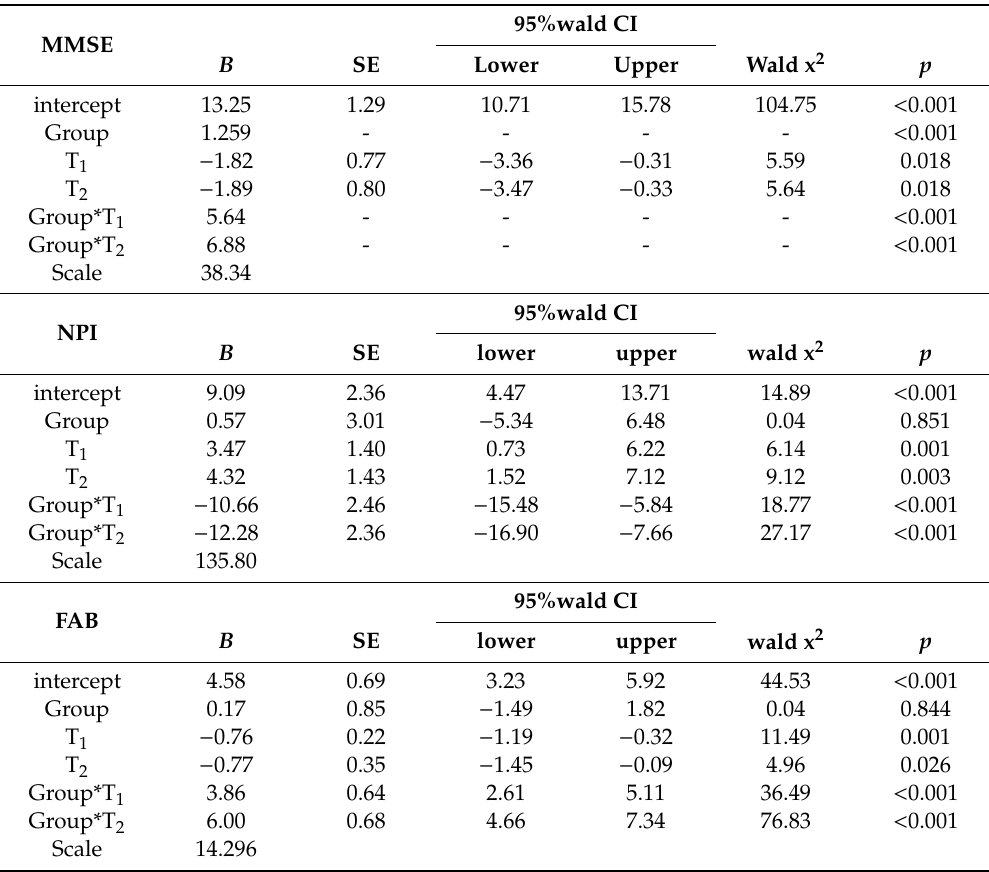
Table 3. E ff ects of the SRLE on patient’s MMSE, NPI and FAB in the post-intervention and 3-month follow-up ( n =